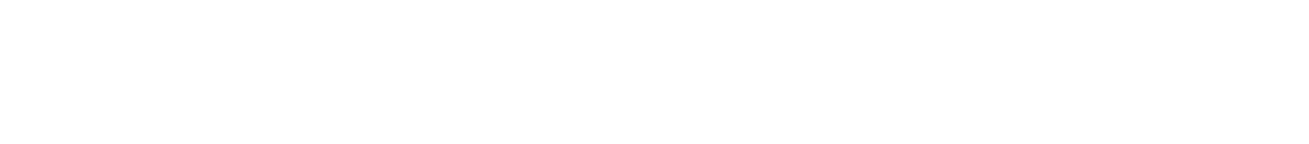
Ewing M et al . BJGP Open 2018; DOI: